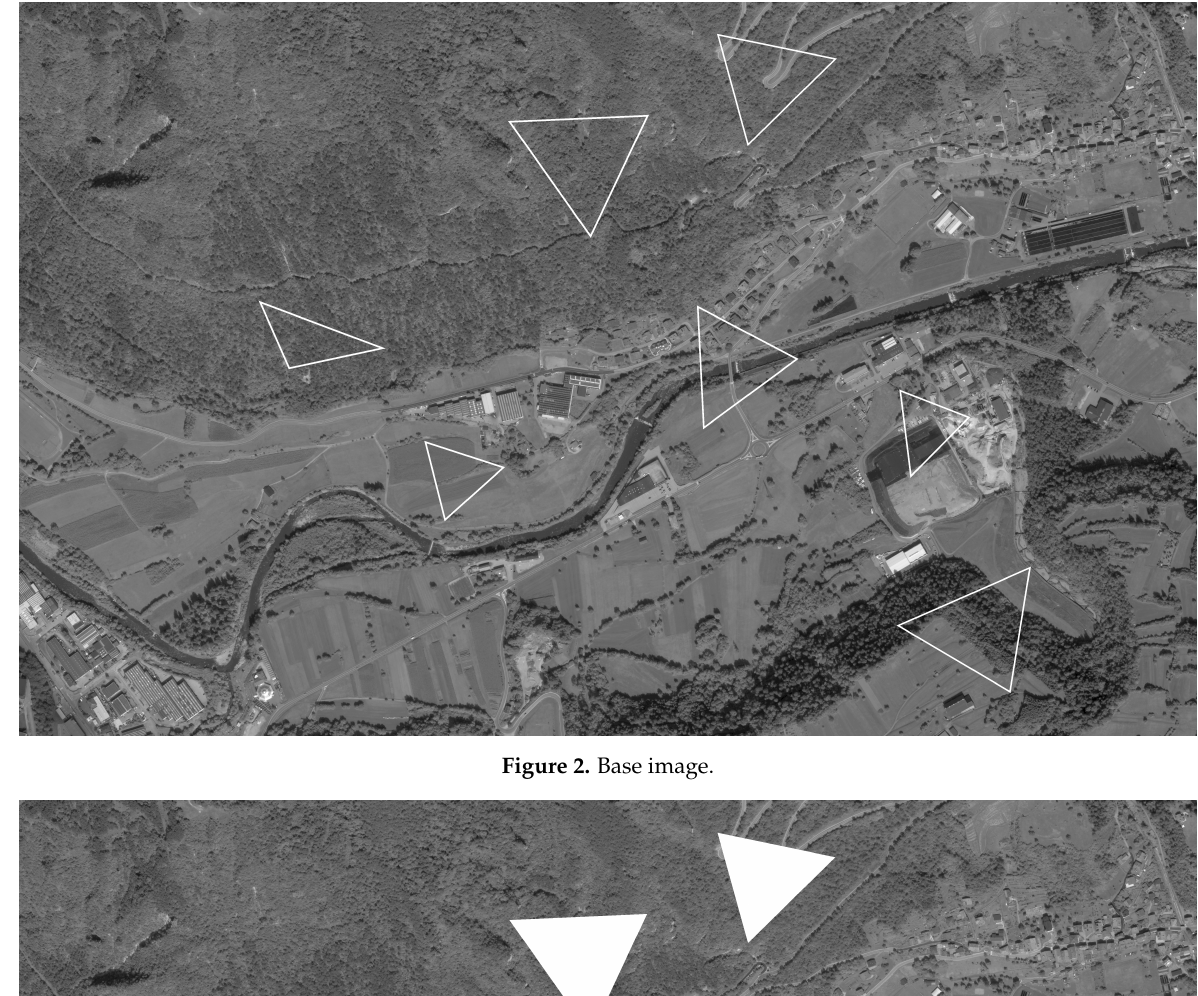
Figure 2. Base image.